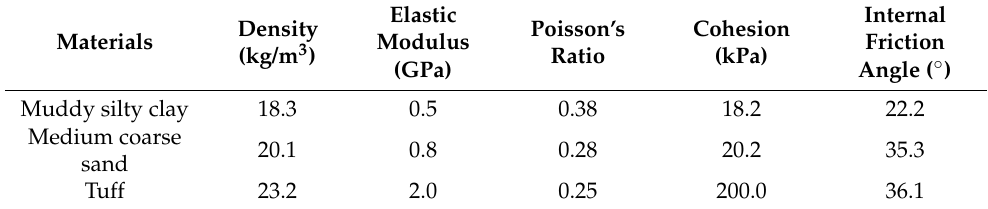
Table 3. Physical and mechanical parameters of surrounding rock.